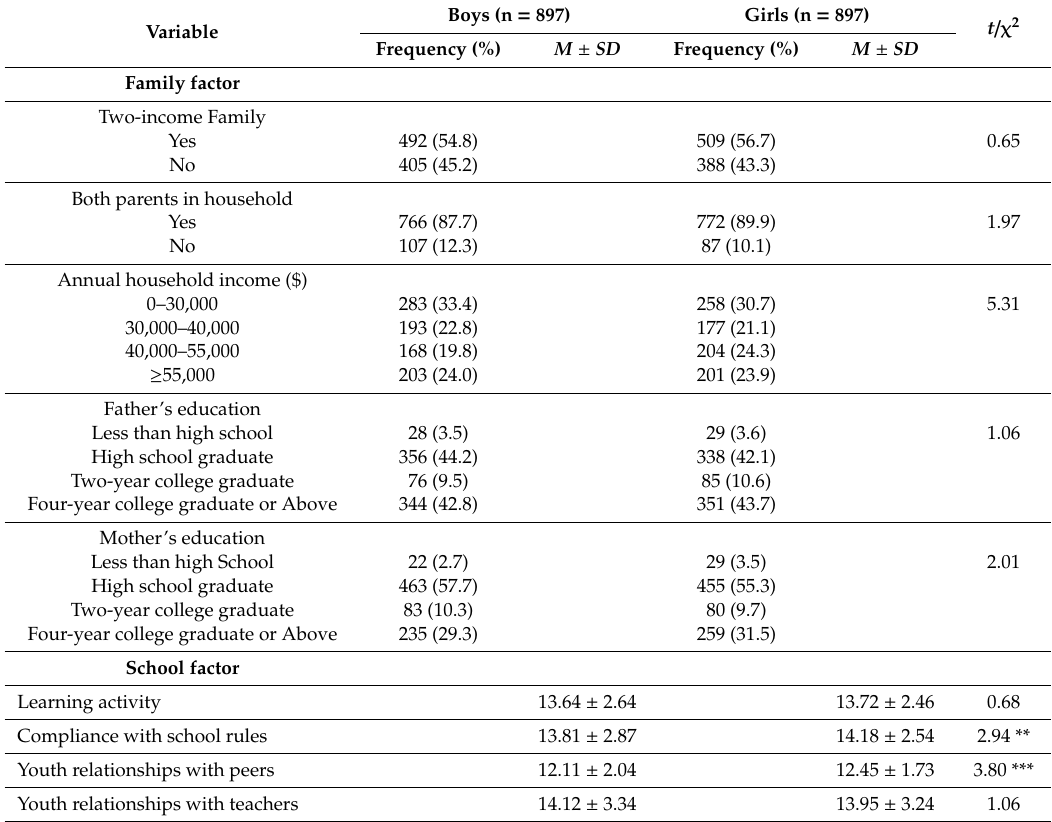
Table 1. Group comparisons of family and school factors between boys and girls at Time 1 ( N = 1794).